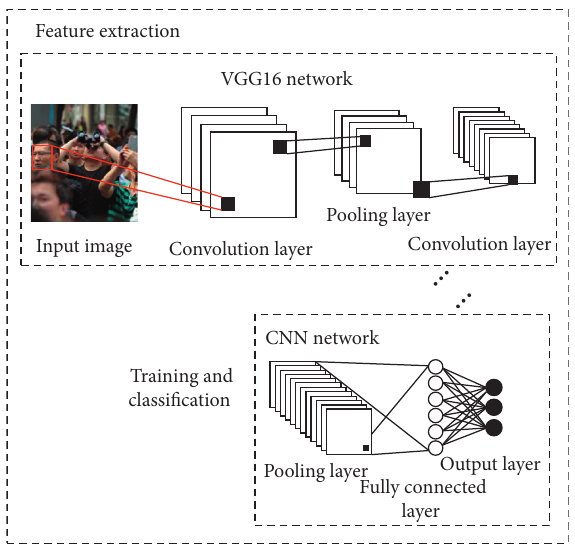
Figure 1: Overall framework of the proposed